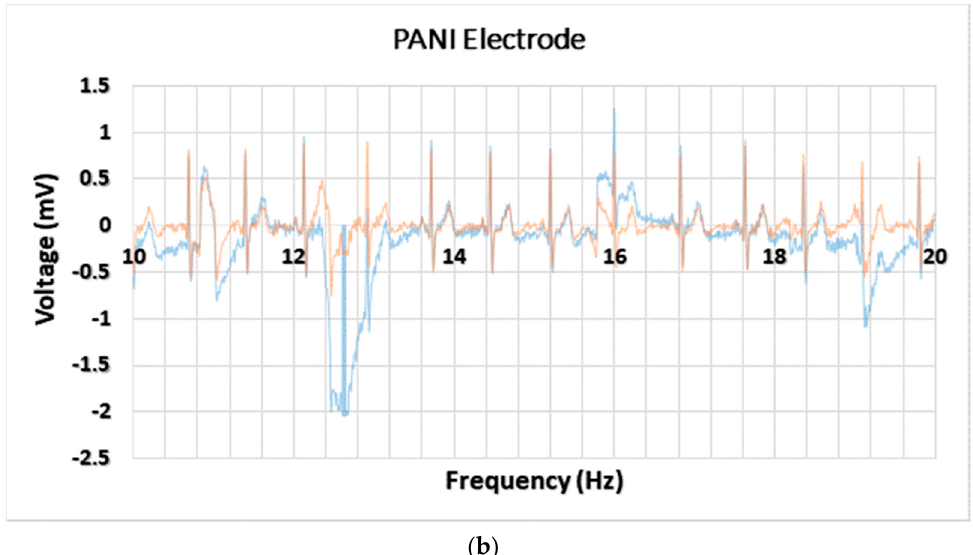
Figure 8. ( a ) ECG result using the standard Ag/AgCl Electrodes (the blue graph is without filtering and the orange line is after the filtering). ( b ) ECG result using the fabricated electrodes (the blue curve is without filtering and the orange curve is after the filtering).